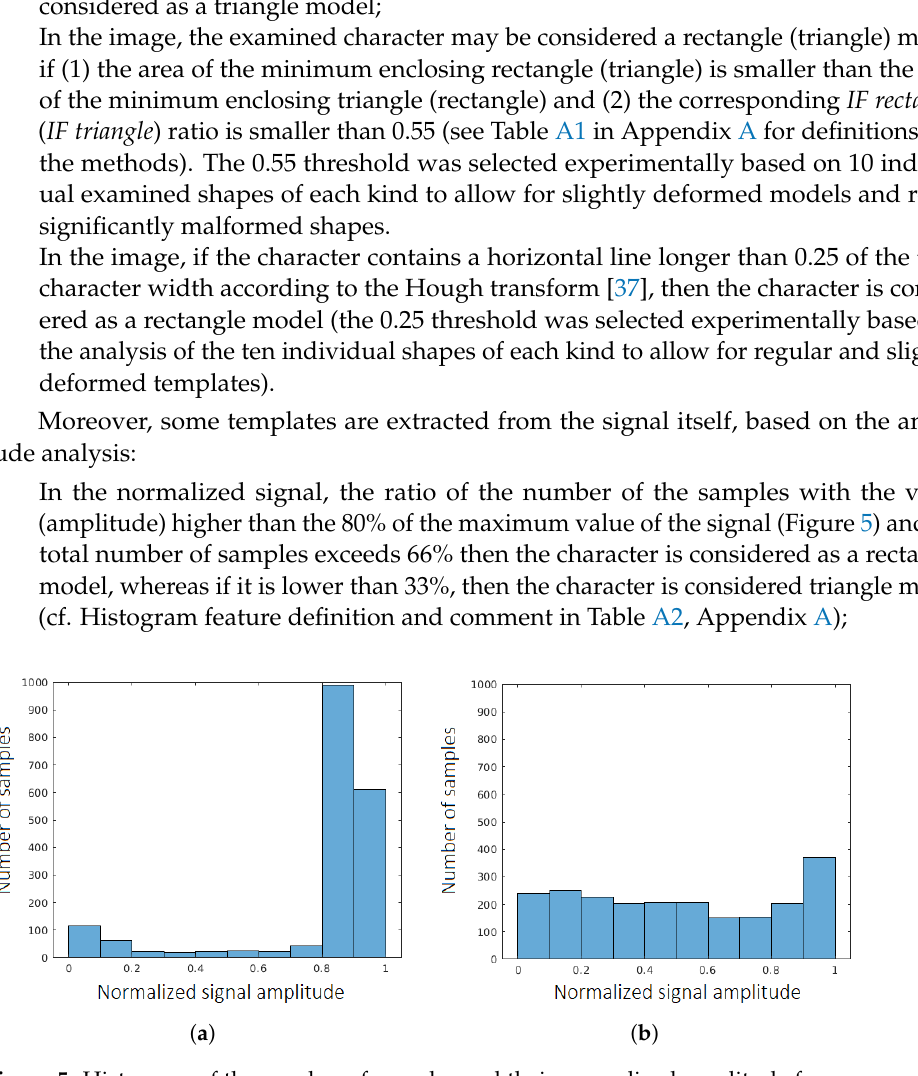
Figure 5. Histogram of the number of samples and their normalized amplitude for an exemplary ( a ) rectangle and ( b )